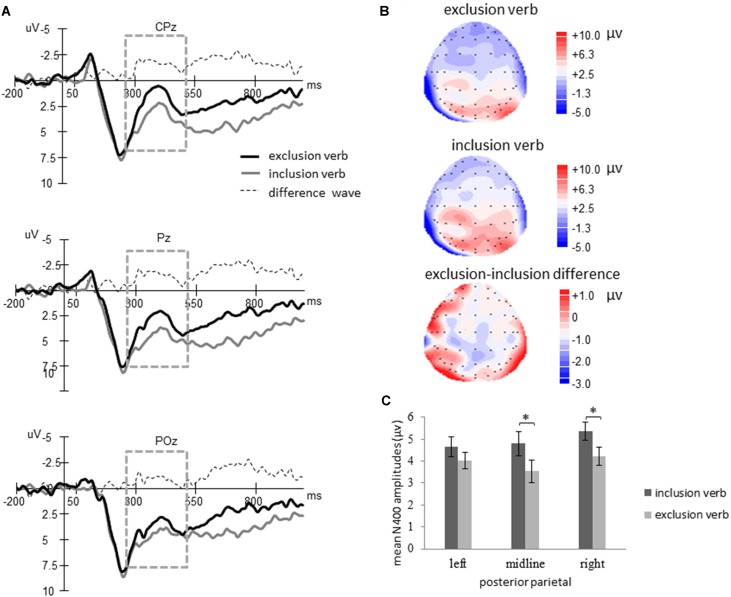
Results for N400. (A) Grand mean waveforms for exclusion, inclusion verbs and their difference (exclusion minus inclusion). (B) The topography map for each condition and their difference at the time course from 250 to 500 ms. (C) Bar graph showing mean N400 amplitudes at posterior parietal area for inclusion versus exclusion word condition. The asterisk indicates a reliable difference between inclusion and exclusion verbs. Error bars indicate standard error.